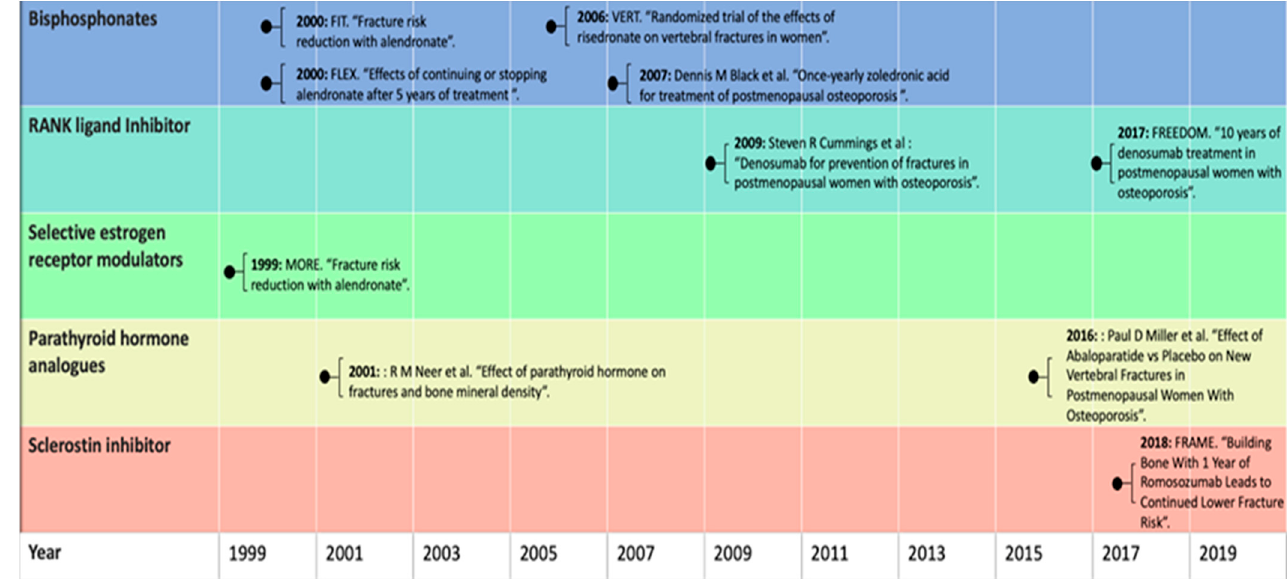
Figure 1. Timeline of randomized control trials in osteoporosis treatments discussed in this review.